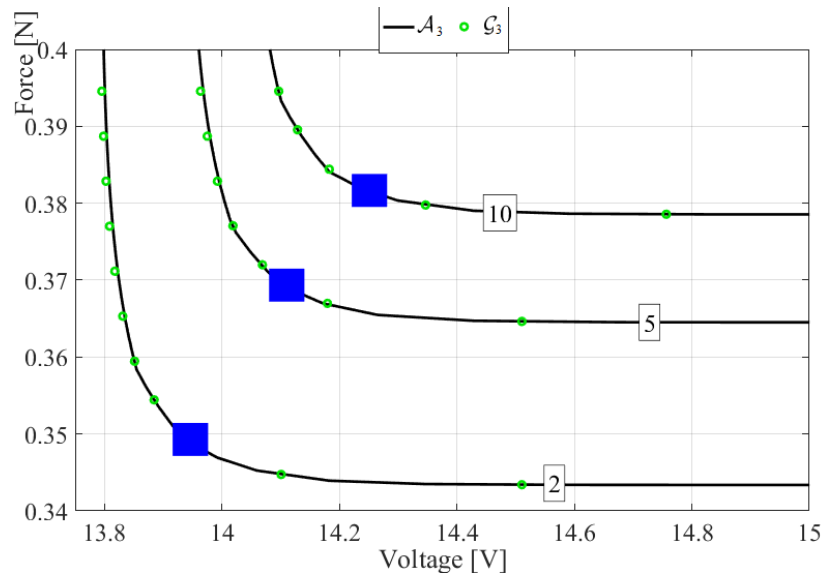
Figure 6. Return periods contour plot for (A) optimised Gumbel logistic G 3 ( ξ , η ) ( ◦ ) and (B) optimised Asymmetric logistic A 3 ( ξ , η ) (—) surfaces. Boxes highlight return periods in years. Solid squares indicate suggested 2D design points.